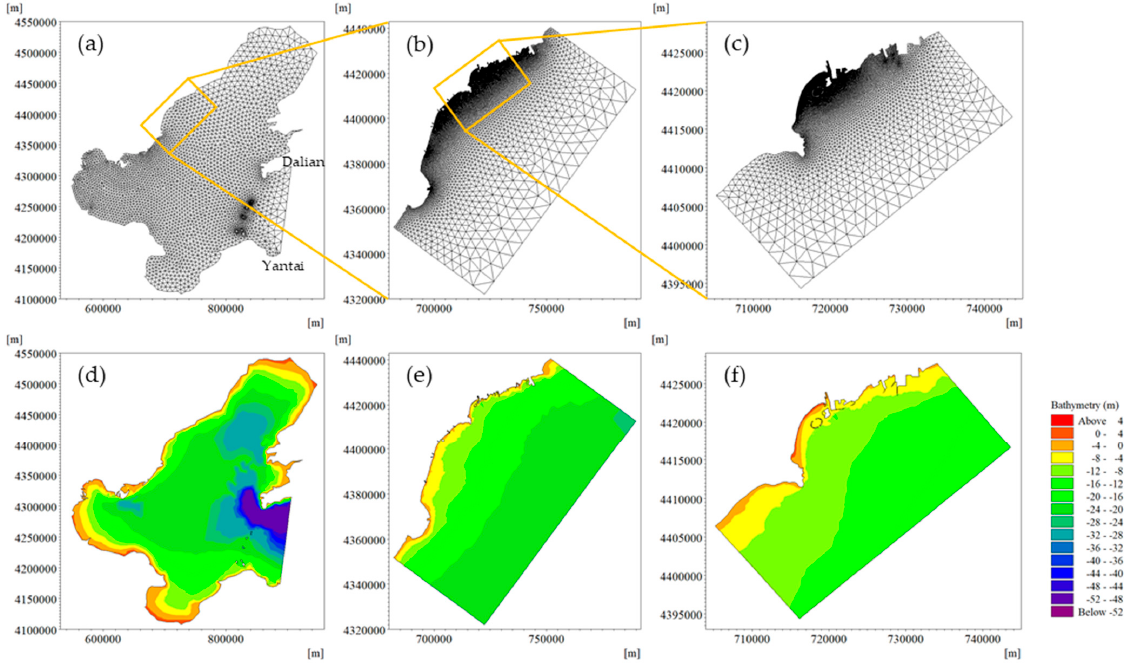
Figure 3. The triple-level scheme of meshes. Grids of ( a ) Bohai Model, ( b ) Qinhuangdao Model, ( c ) Jinmeng Bay Model. Bathymetries of ( d ) Bohai Model, ( e ) Qinhuangdao Model, ( f ) Jinmeng Bay Model. The yellow squares show the refined areas in the lower level meshes. Table 1. Details of the triple-level scheme of meshes.